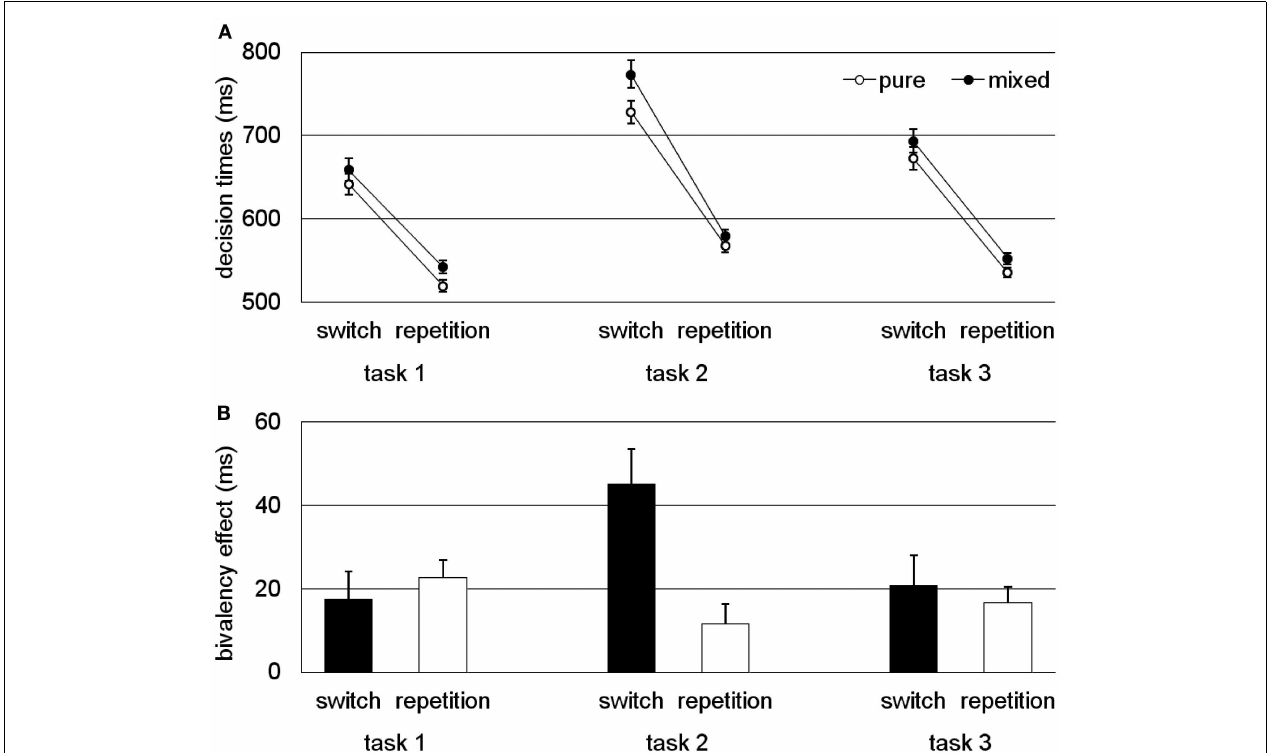
performance on univalent stimuli for switch and repetition trials in pure and mixed blocks). (B) Bivalency effect (i.e., difference between univalent trials from the pure block and those from the mixed block). Results adapted from Rey-Mermet and Meier (2012b) averaged across experiments and